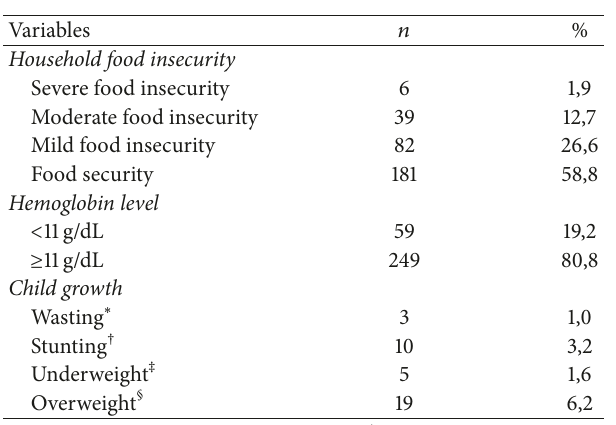
Table 1: Nutritional status of preschool children, according to anthropometric indicators, hemoglobin level, and household food insecurity. Taubat´e, S˜ao Paulo, Brazil, 2014.